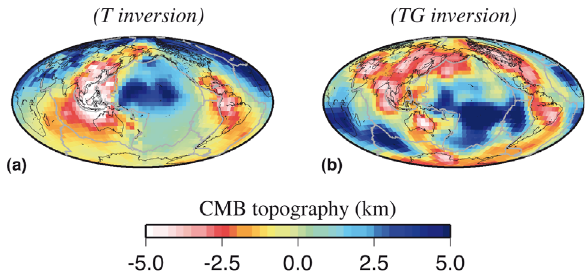
Figure 2. Maps of CMB topography (km) obtained from the entire P , PcP , S data set. The maps are obtained by jointly inverting ISC and Houser et al. (2008) data with a purely tomographic approach T (a), and with a tomographic-geodynamic approach TG (b), inte- grating the mantle shear velocity anomaly modulated by the sensi- tivity kernels as in Equation (4). The TG approach assumes a laterally here) and constant scaling between seismic velocity ( y S